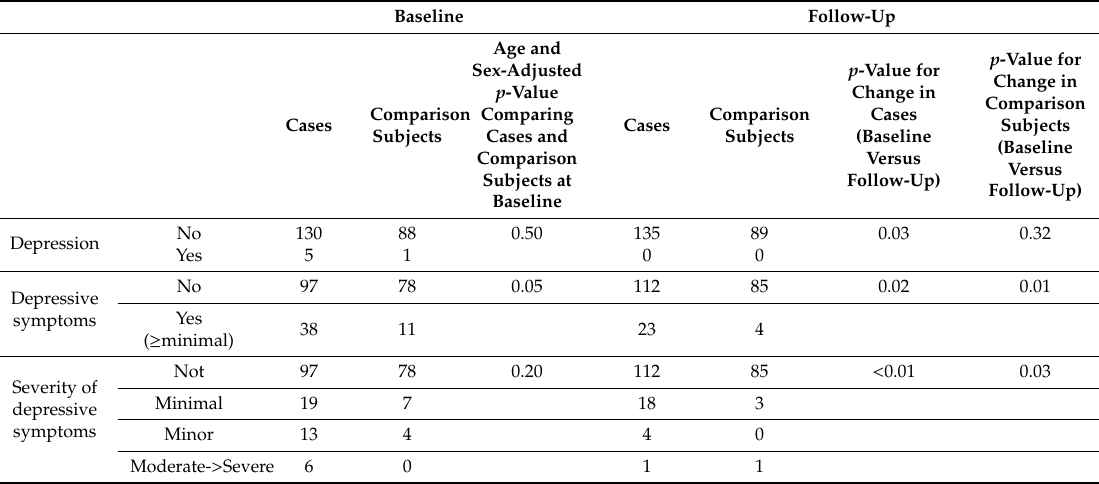
Table 4. Depression symptoms of cases and comparison subjects, at baseline and follow-up.